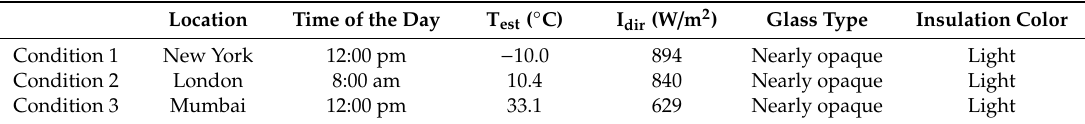
Table A2. Environmental parameters and physical properties of the glass at peak conditions of temperature gradients for the analyses conducted in the